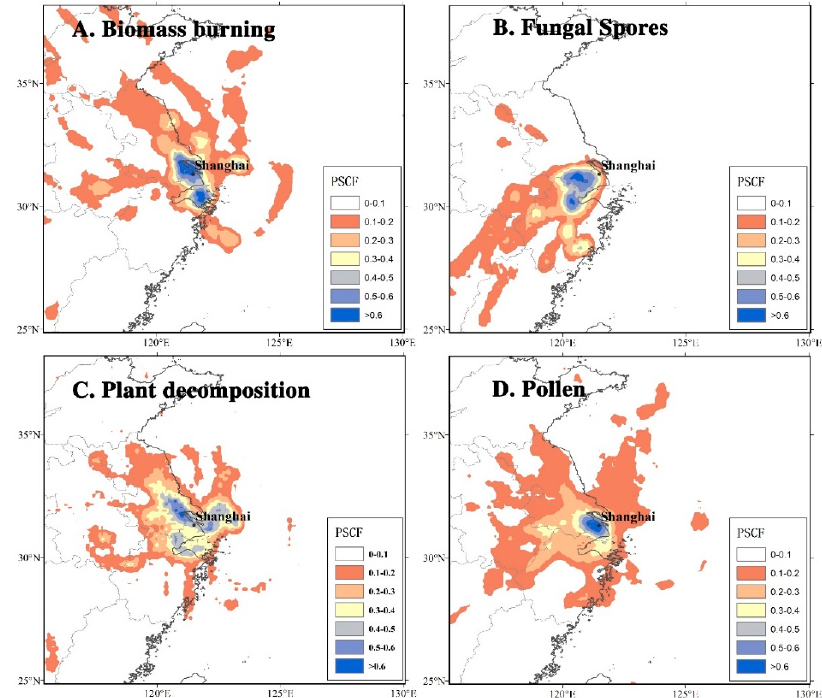
Figure 6. Potential source regions for the source of saccharides in Shanghai: ( A ) Biomass burning; ( B ) fungal spores; ( C ) plant decomposition; and ( D ) pollen.